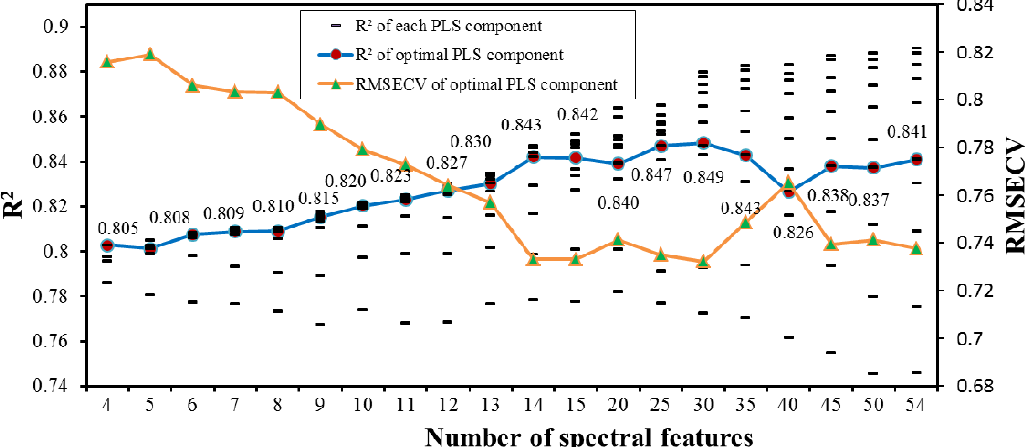
Figure 4. Variation in the coefficient of determination for different numbers of spectral features analyzed via partial least squares regression (PLSR). Note: The black horizontal dashes represent the coefficients of determination of the first ten PLS factors for different numbers of spectral features. Each optimal PLS factor is marked as a red circle, and the corresponding RMSECV is marked as green